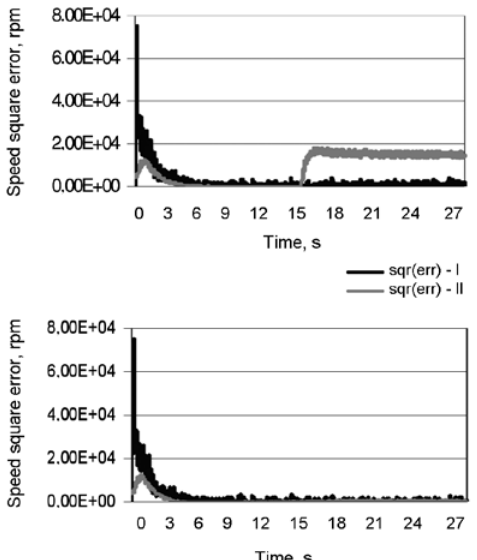
Fig. 6. Related square error ( sqr(err) ) of speed for estimation in system I/II during the attachment process of the BLDC drive to the engine and launching hybrid process with the BLDC drive respectively – high level of measurement